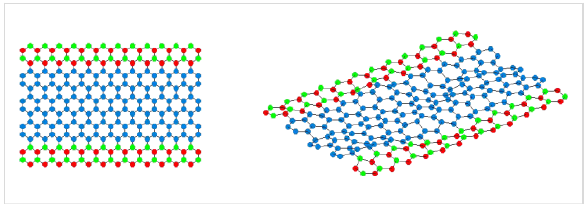
Figure 1: Top view of a 5h-2BN-ZGNR (left panel) and the same GNR with surface roughness (right panel). The blue circles represent carbon atoms while boron and nitrogen dopants are shown in green and red,